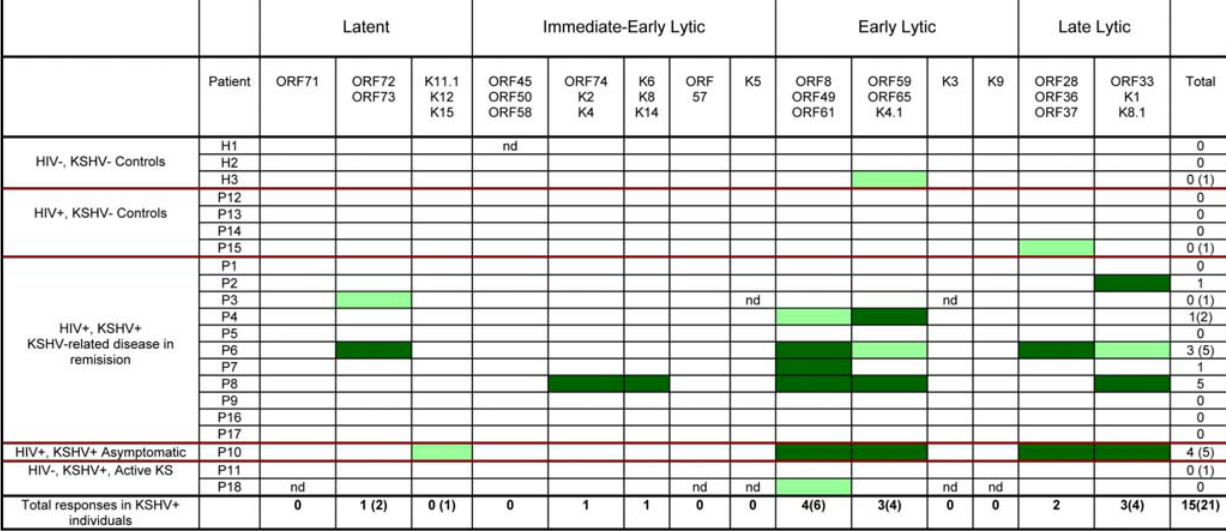
Figure 5. Summary of CD4 responses to KSHV ORFs by all study participants. Dark green boxes represent positive responses; light green boxes represent borderline responses; unfilled boxes represent no response; nd indicates not done due to insufficient numbers of available PBMCs.